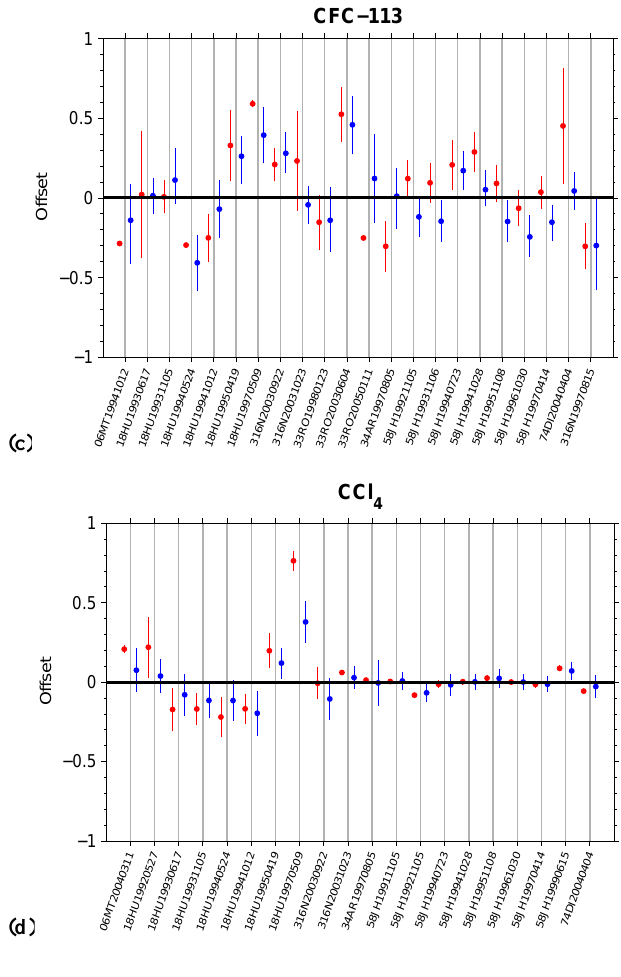
Figure 4 Figure 4. Continued.